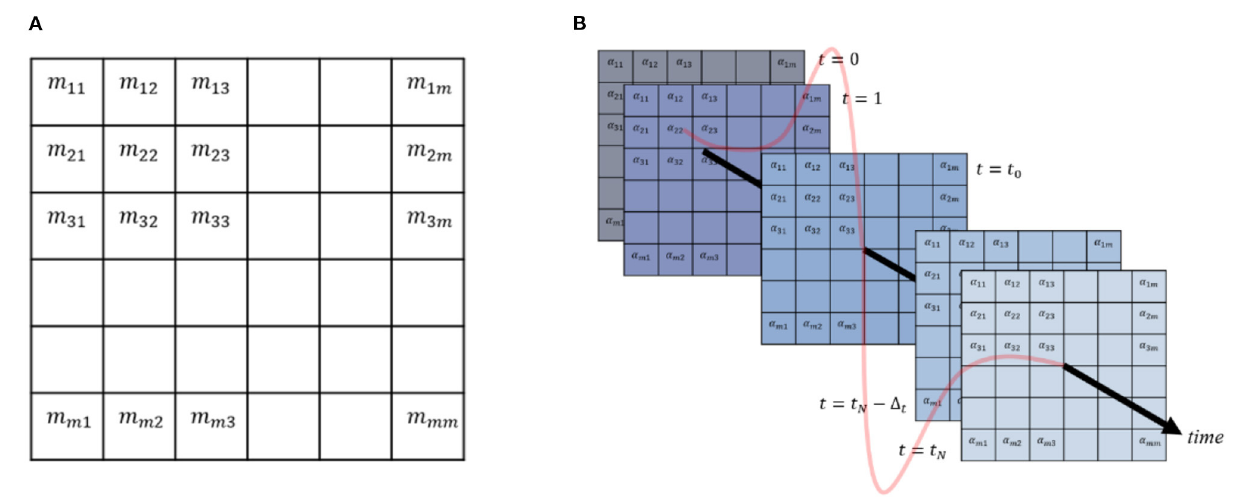
FIGURE 4 | Applying Algorithm 1 to transform the OD matrix data into the time-dependent mobility rates: (A) Origin-Destination matrix; (B) time-dependent mobility rates.